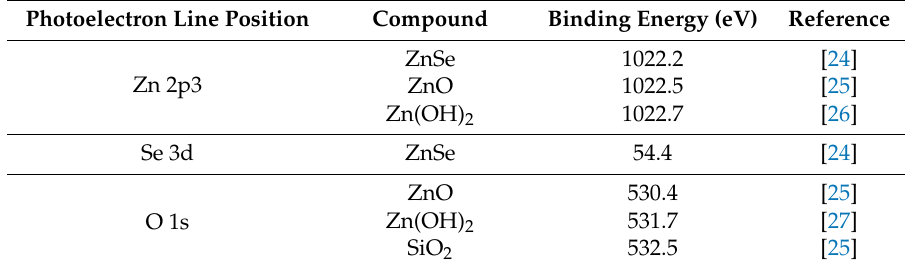
Table 1. Binding energies of ZnSe, ZnO, and Zn(OH) 2 for the photoelectron line positions of Zn 2p3, Se 3d, and O 1s.